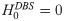
β-Power as a function of the stimulation frequency (fDBS) for different pulse shapes of the stimulation pattern.The β-Power has been normalized with respect to that obtained for the system in the oscillatory state without stimulation (H0DBS=0). This result suggest that the β-Power is invariant to the change in the shape of the pulses, and only depends on the area of the pulse constituting the stimulation pattern.